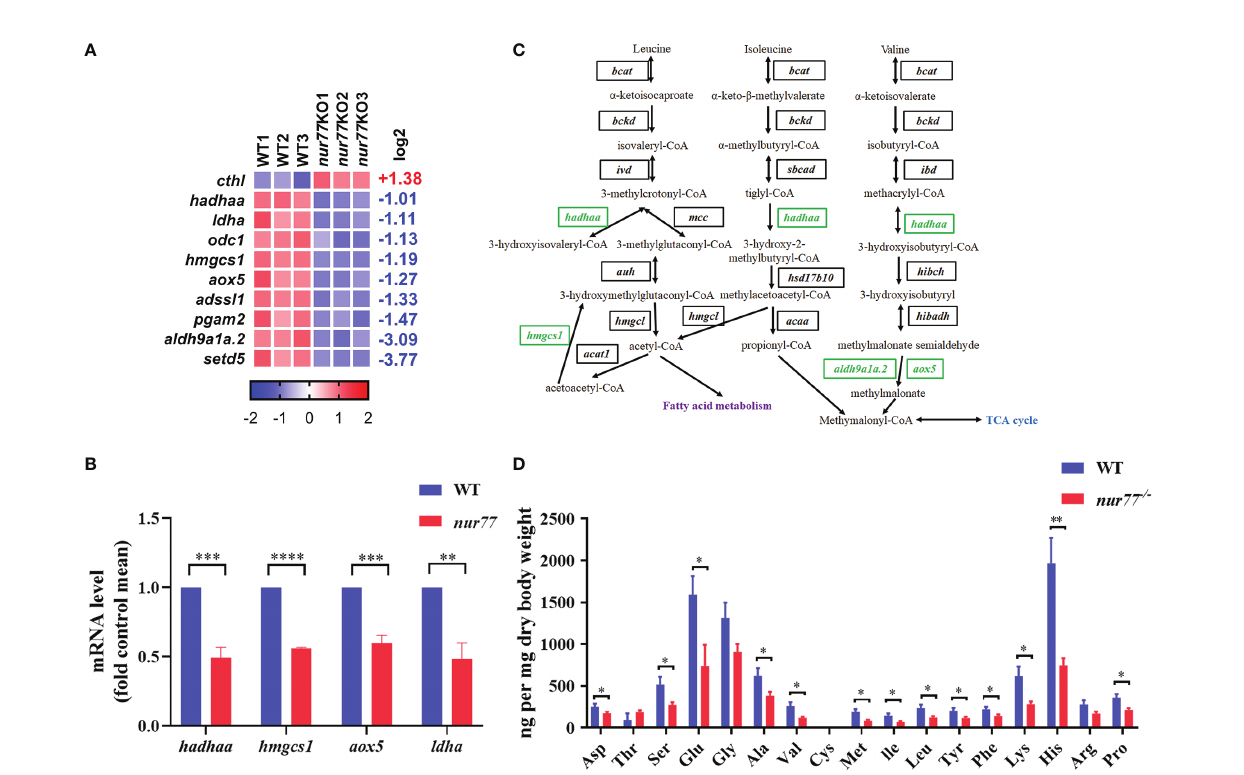
FIGURE 3 | Nur77 regulates amino acid metabolism in zebra fi sh larvae. (A) Heatmaps of transcripts in amino acid metabolism enrichment. Colors represent high (red), low (blue), or average (white) expression values based on Z-score-normalized fragments per kilobase per million mapped read (FPKM) values for each gene. The Z-score indicators are shown under each map. The fold change (log2) is shown on the right. (B) The validation of the expression levels of differentially expressed genes by qRT-PCR analysis in the categories of amino acid metabolism ( n = 3). (C) Disturbed valine, leucine, and isoleucine degradation. Blocks represent transcript-encoded enzymes. Green blocks represent downregulated genes, and black blocks represent unchanged genes. (D) Amino acids compositions in WT and nur77 − / − embryos. Results are represented as means with standard errors ( n = 3); * p < 0.05; ** p < 0.01; *** p < 0.001, **** p < 0.0001 by